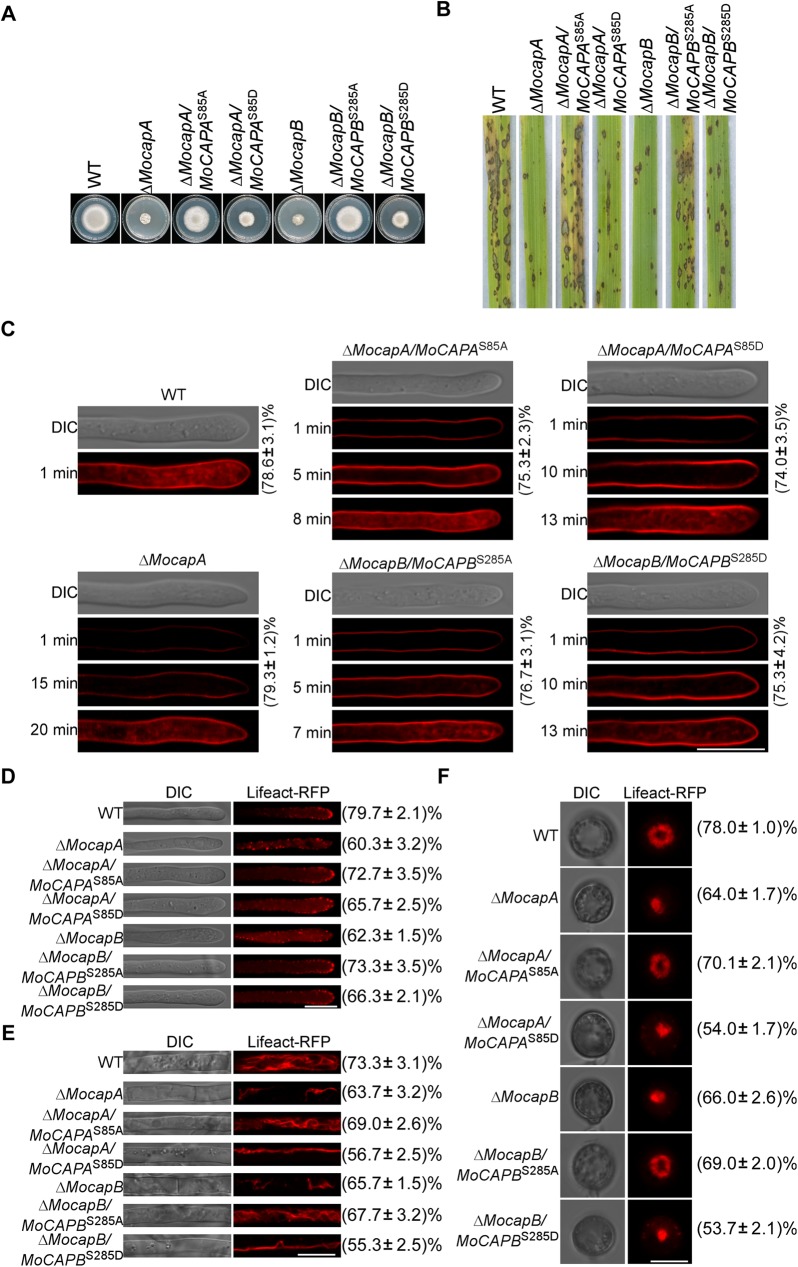
The phosphorylation of MoCapA and MoCapB negatively regulate growth, virulence, endocytosis and F-actin assembly.(A) Growth of WT, ΔMocapA, ΔMocapA/MoCAPAS85A, ΔMocapA/MoCAPAS85D, ΔMocapB, ΔMocapB/MoCAPBS285A and ΔMocapB/MoCAPBS285D. Seven-day-old cultures of different strains on CM plates. (B) Pathogenicity of WT, ΔMocapA, ΔMocapA/MoCAPAS85A, ΔMocapA/MoCAPAS85D, ΔMocapB, ΔMocapB/MoCAPBS285A and ΔMocapB/MoCAPBS285D. Disease symptoms on rice seedlings sprayed with conidial suspensions at 7 dpi. (C) The effect of phosphorylation of MoCAP on endocytosis. The numbers indicate the percentage of the hyphae exhibiting different endocytosis as seen in figure (n = 100). Strains were cultured in liquid CM for 48 h, then stained with FM4-64 and examined under confocal fluorescence microscope (Zeiss LSM710, 63×oil). The camera exposure is indicated in seconds (800 ms). Here ΔMocapA represents all ΔMocap mutants as they exhibit the similar defect in endocytosis as seen in Fig 6. (D and E) Actin morphologies in hyphae were observed after strains were cultured in liquid CM for 48 h. The numbers indicate the percentage of the hyphae exhibiting actin morphologies as seen in figure (n = 100). (F) Actin morphologies in appressoria were observed. The numbers indicate the percentage of the appressoria exhibiting actin morphologies as seen in figure (n = 100). Observations were made with a confocal fluorescence microscope (Zeiss LSM710, 63×oil). Bar = 5 μm. The above experiments repeated three times with the same results.